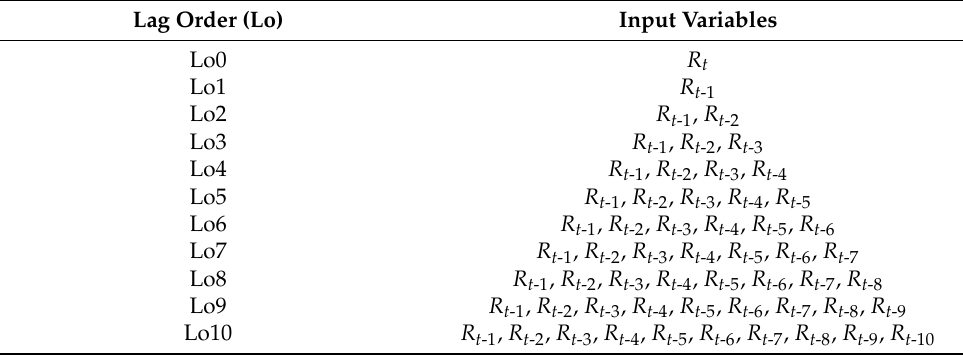
Table 3. Input models based on time lag order